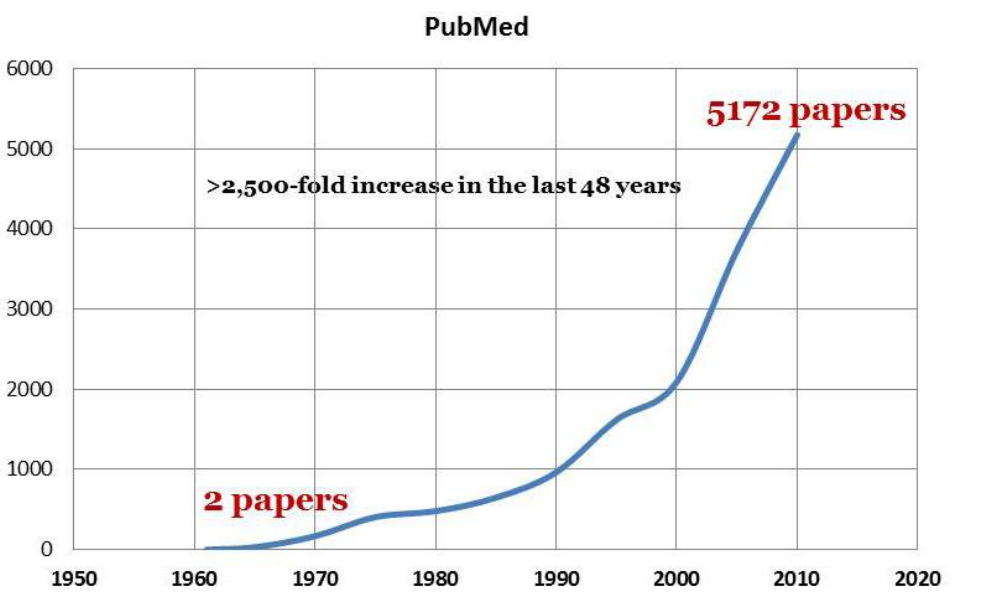
Figure 1. Publications on religion and health